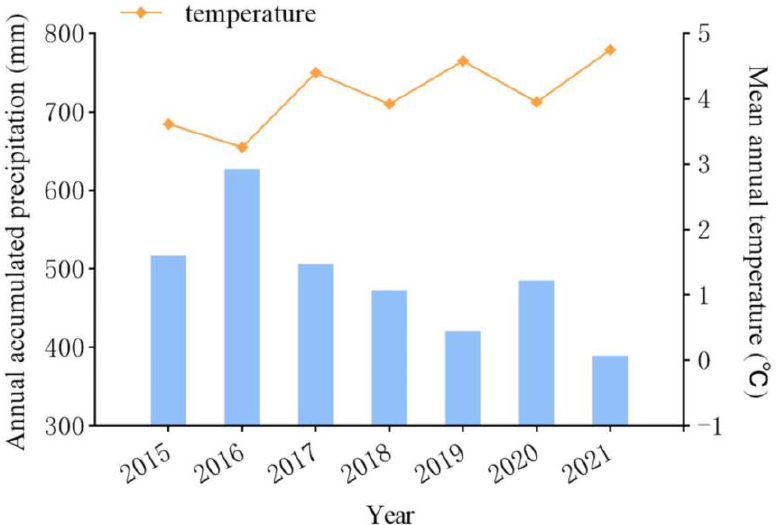
Figure 5. Annual precipitation and average annual temperature from 2015 to 2021.